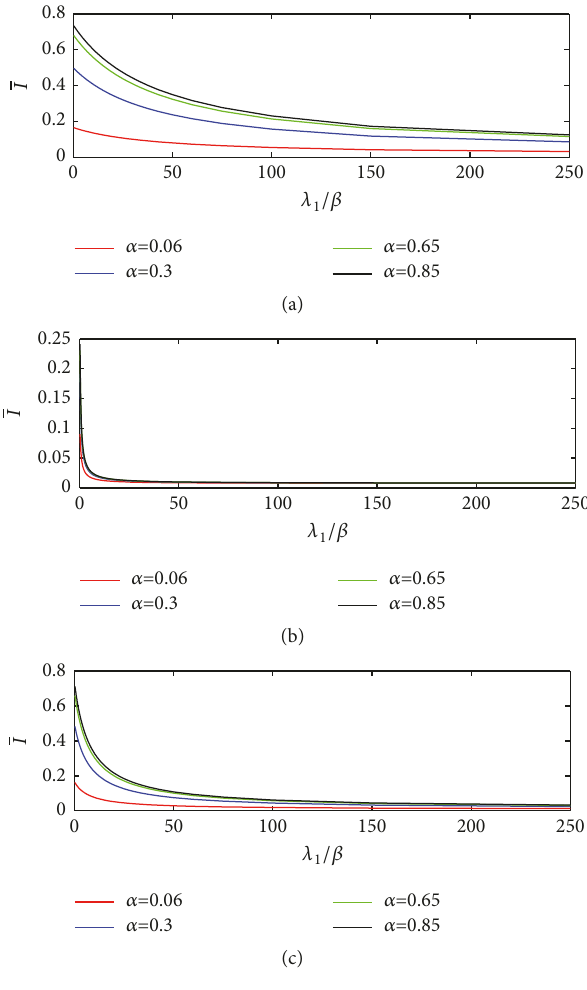
Figure7:Theinfluenceoftheactualspreadingrate 𝜆 1 /𝛽 onnetwork average infected steady state at different values of 𝛼 for the fully connect network (a), NW small-world network (b) and BA scale- free networks (c). The curves from bottom to top in each subplot correspond to the value of 𝛼 = 0.06,0.3,0.65,0.85 ,